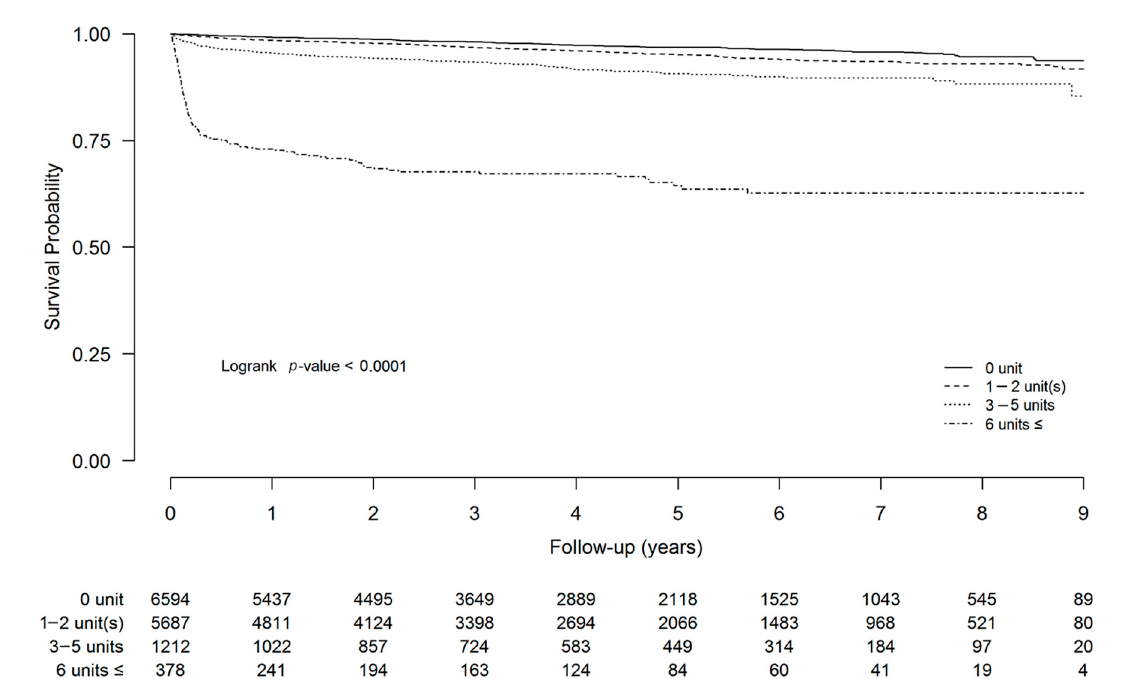
Figure 2. Patient survival according to the amount of perioperative RBC transfusion. Long-term survival analysis of up to 10 years after KT showed higher survival rates in patients who received less RBC transfusion (log-rank test p < 0.001). Abbreviations: KT, kidney transplantation and RBC, red blood cell.